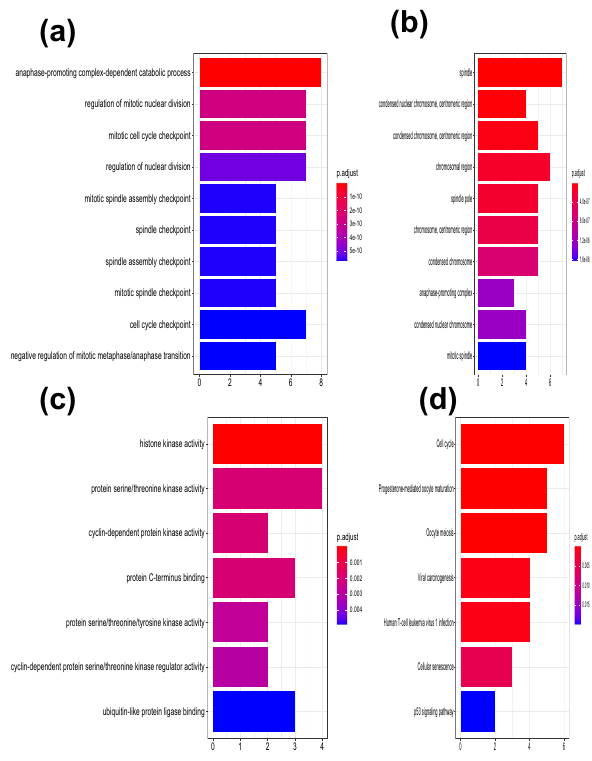
Figure 5. GO and KEGG functional enrichment analysis. ( a ) Top 10 terms in BP category. ( b ) Top 10 terms in CC category. ( c ) All terms in MF category. ( d ) All terms in KEGG pathway analysis. (The figures were created by